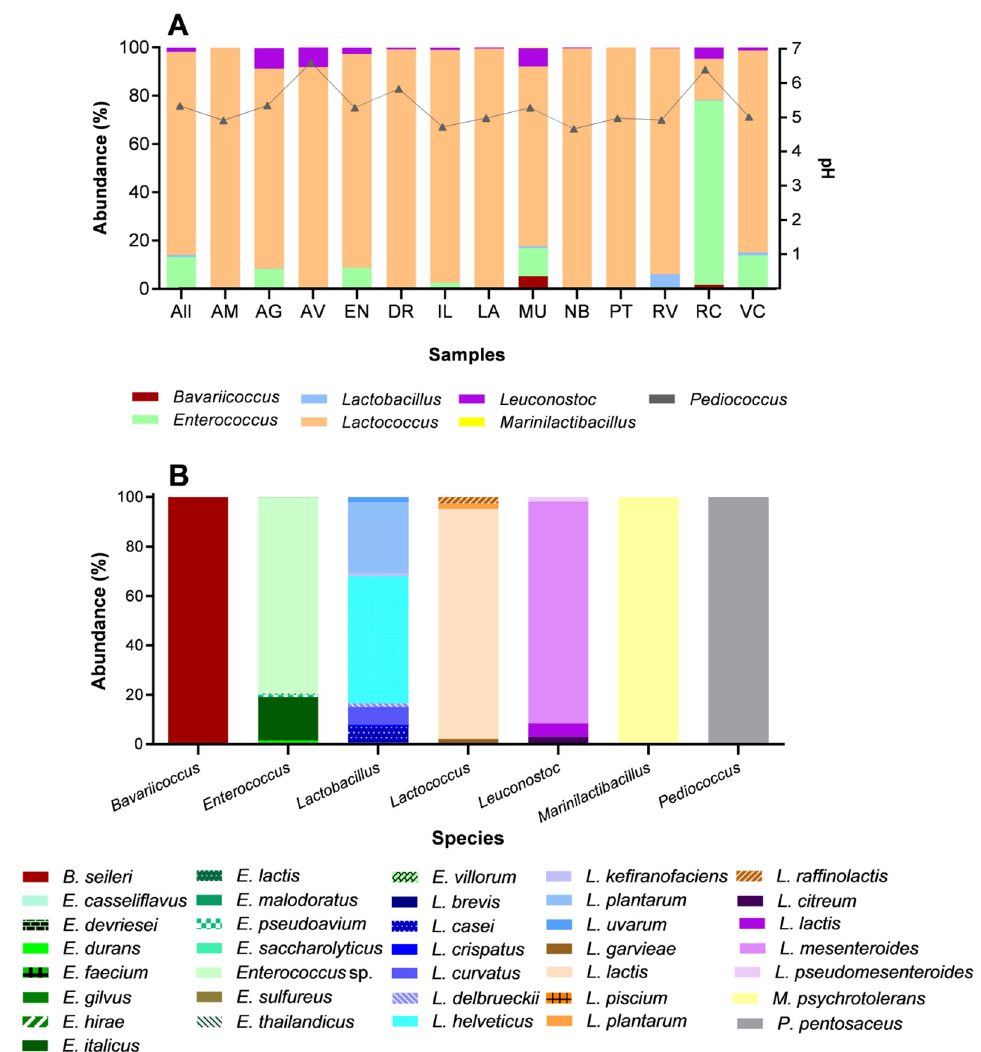
Figure 2. Total bacterial abundance and pH variation of artisan cheeses with seven days of maturation. ( A ) Genus abundance; ( B ) species abundance in each genus. (All) represents the sum of all samples and the average pH value. The triangles indicate the pH values.